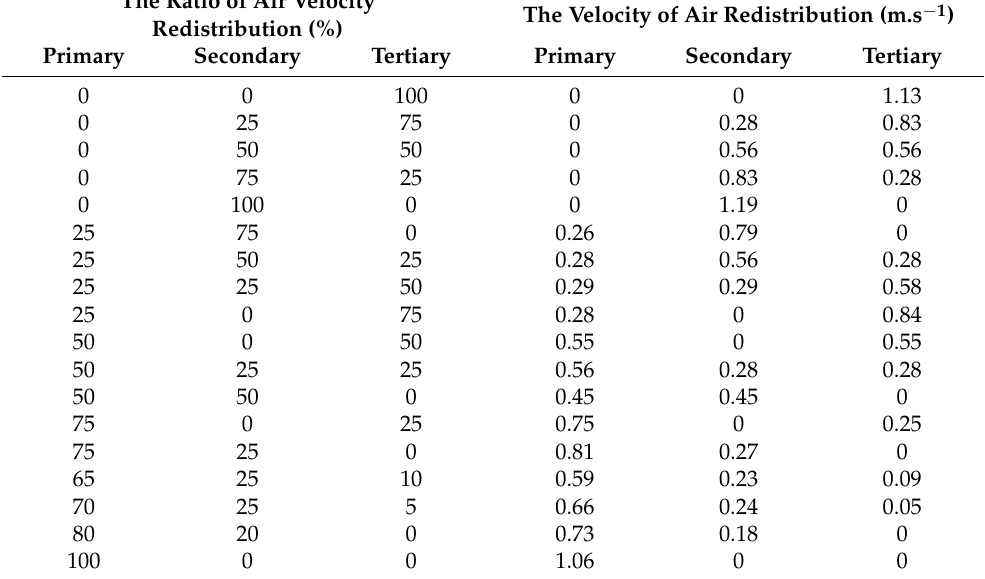
Table 2. The resulting calculated air supply